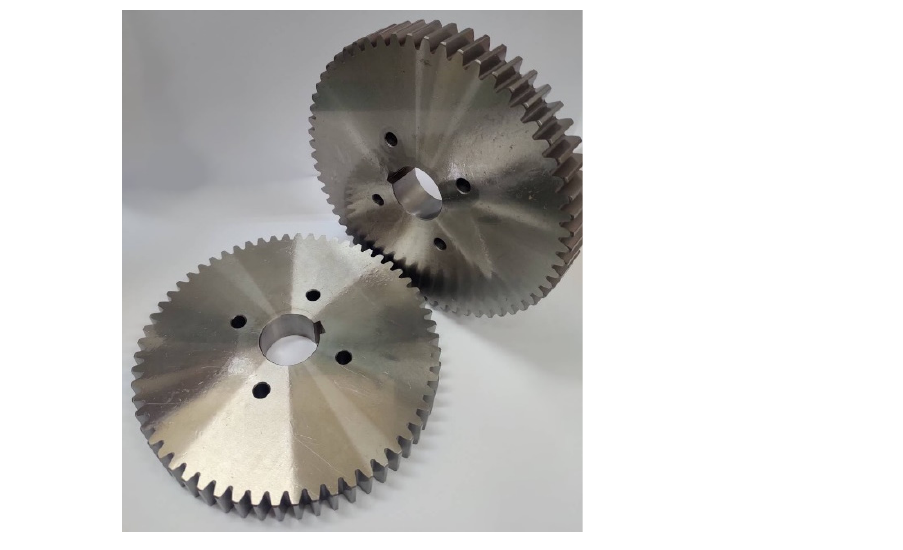
Figure 7. Gear dynamic tester.